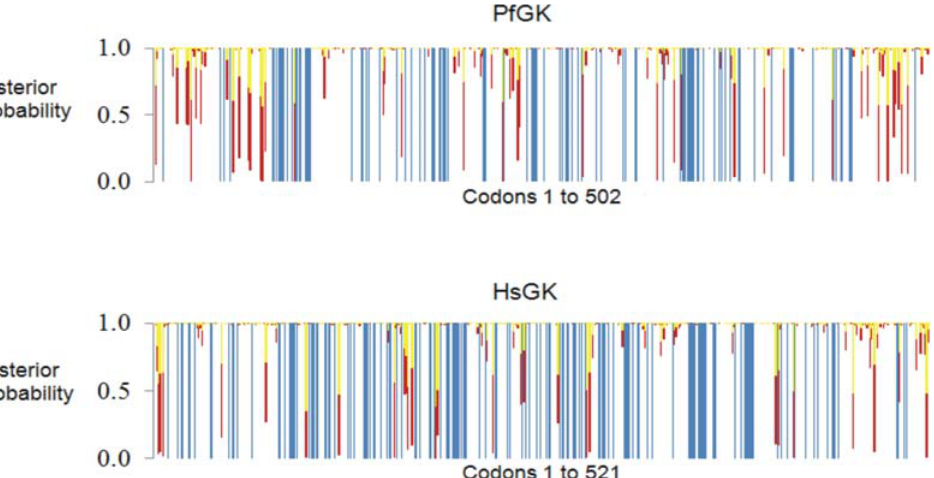
Figure 2. Posterior probabilities for four categories of v across GK coding sequences. The Bayes Empirical Bayes posterior probability estimates (BEB) determined from the PAML analysis of the protozoan and metazoan clades were plotted for each category of v across the P. falciparum (PfGK) and human (HsGK) GK coding sequences, respectively. Residues under extreme purifying selection (blue lines) are potential drug target sites. Categories for v are indicated with colored bars: yellow ( v . 1.0, positive selection), red ( v =1.0, neutral selection), white (0.1 , v , 1.0, purifying selection), and blue ( v # 0.1, extreme purifying selection). The v , 0.1 category was defined by combining PAML (BEB . 99%) and SLR (p , 0.01) data.